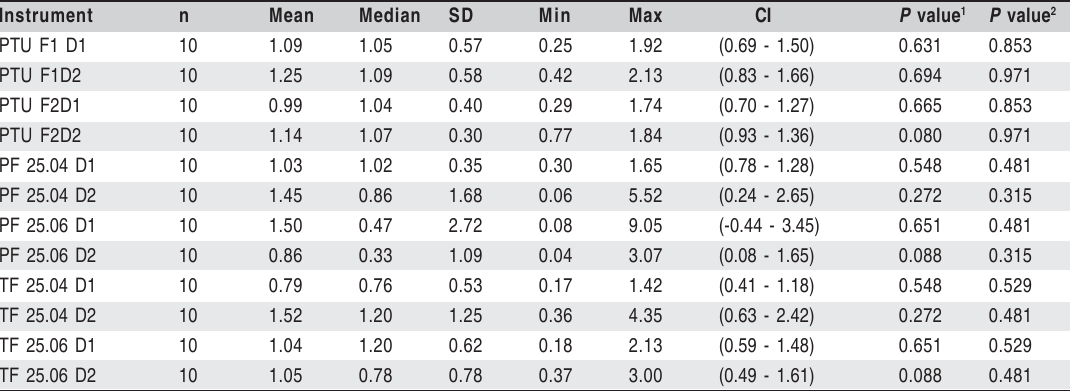
Table 1- Main descriptive statistics of the buccolingual and mesiodistal measurements according to the instrument used Instrument